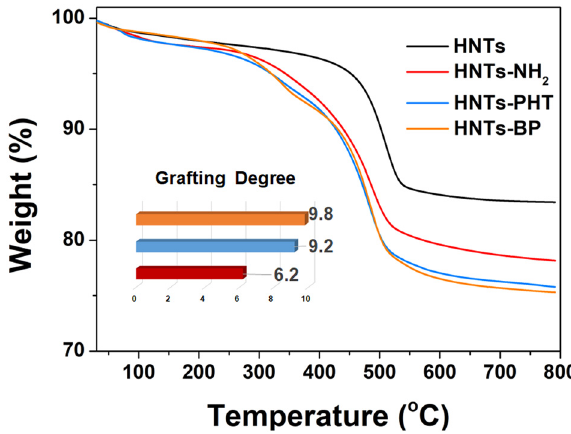
Figure 3: TGA curves of HNTs, HNTs - NH 2 , HNTs - PHT and HNTs -